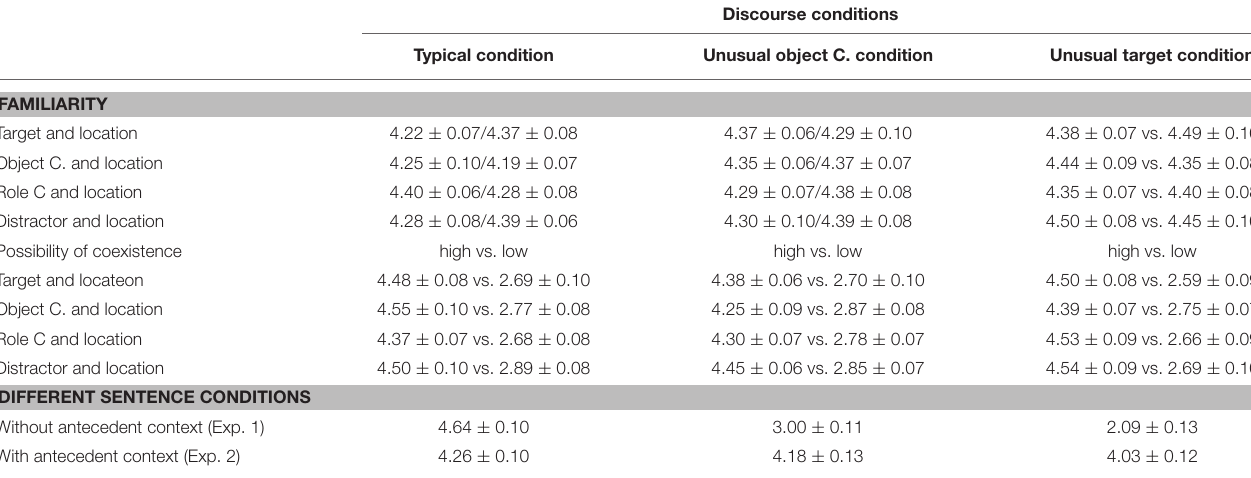
TABLE 1 | Information on ratings ( M ± SE ) of words and sentences in Experiments 1 and